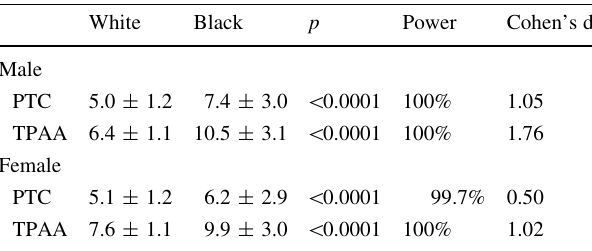
Table 3 Sub-group analysis showing the influence of ethnicity on the amount of posterior tibial slope with posterior tibial cortex (PTC) and tibial proximal anatomical axis (TPAA) methods in patients of the same gender White